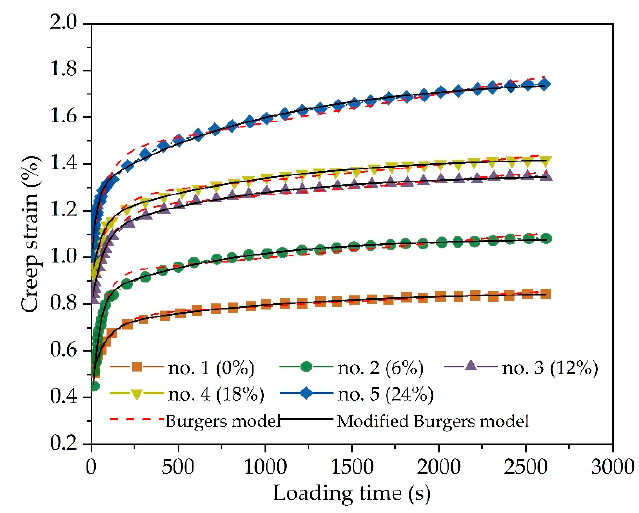
Figure 4. Comparison of Burgers model and modified Burgers model of AC-16 under different chloride salt concentrations.